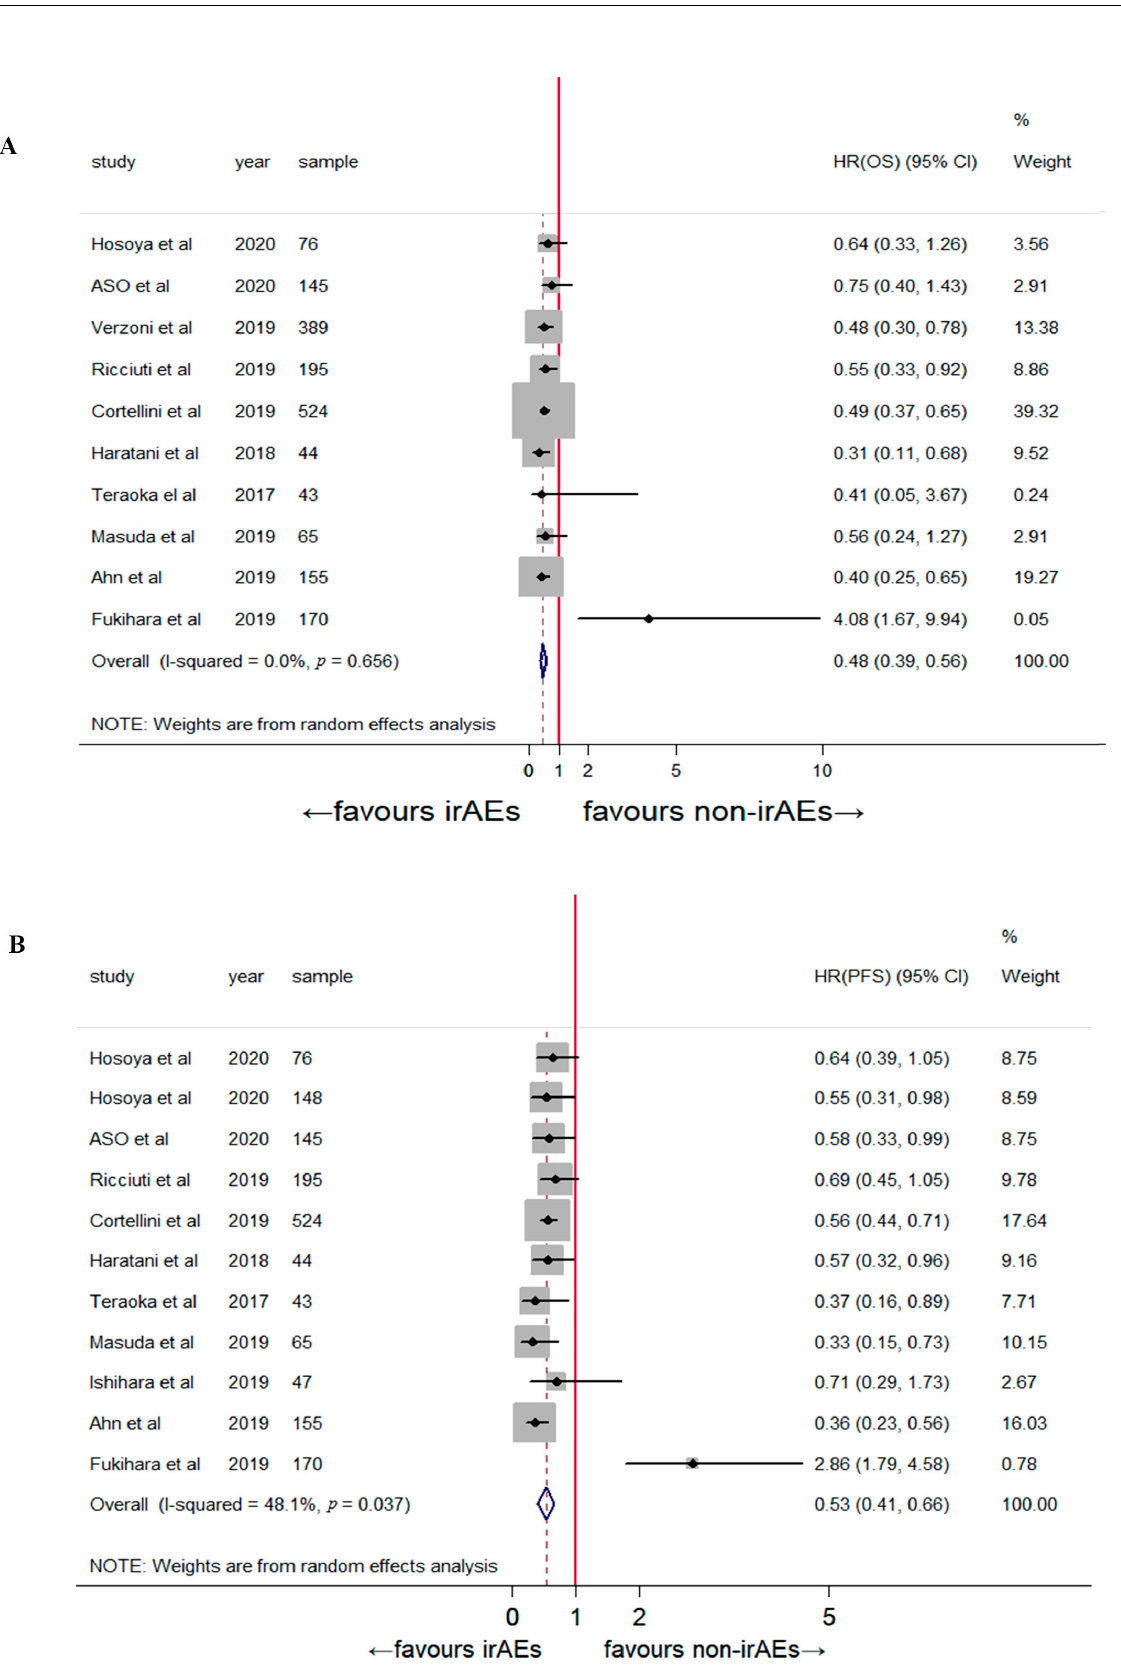
Figure 2. The association between early-onset irAEs and ( A ) overall survival [2,8,13–17,20–22] and ( B ) progression-free survival